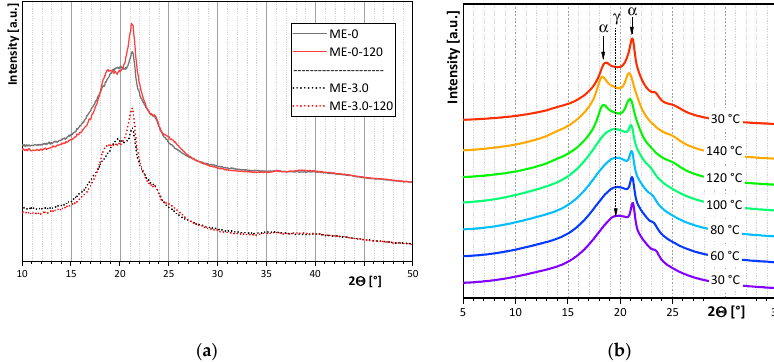
Figure 8. Wide angle X-Ray scattering (WAXS) curves of ( a ) melt-extruded films as a function of different filler amounts and thermal treatment, ( b ) ME-0 at different temperatures.